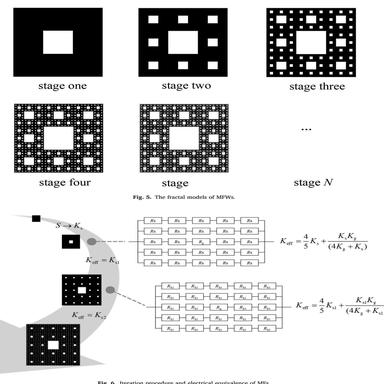
Iteration procedure and electrical equivalence of MFs.